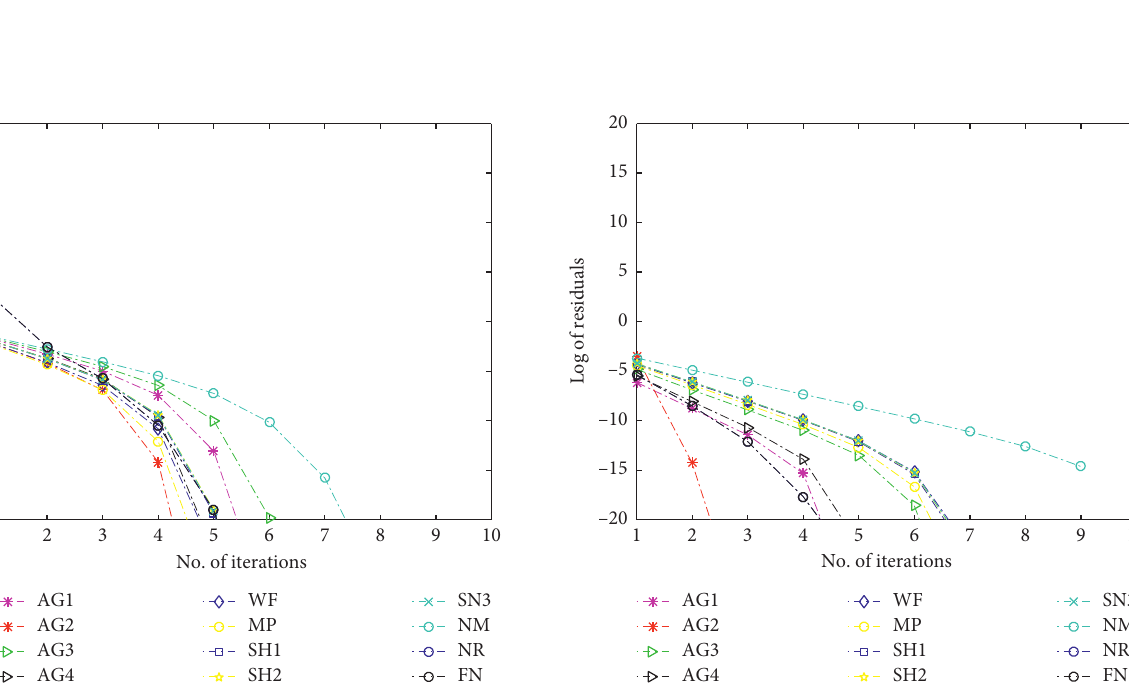
Figure 1: Log of residuals for equation (75). Figure 2: Log of residuals for equation